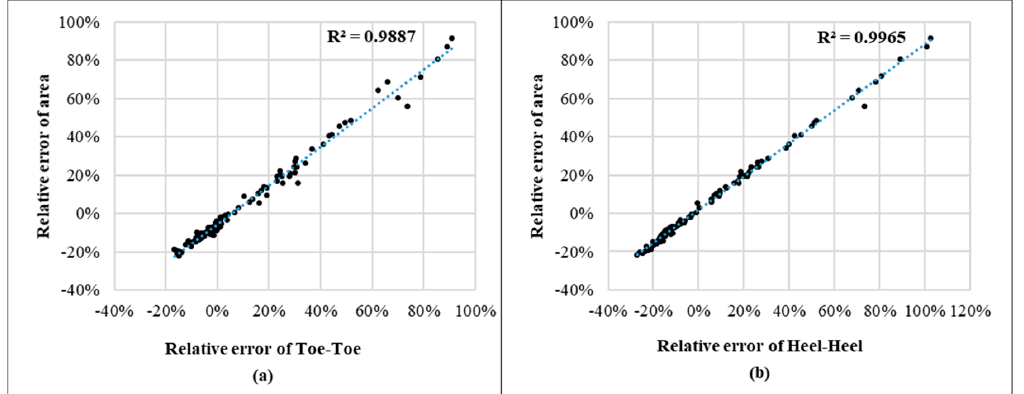
Figure 14. Scatterplots and regression lines of ( a ) Relative error of toe-toe vs. relative error of BOS area, and ( b ) Relative error of heel-heel vs. relative error of BOS area.